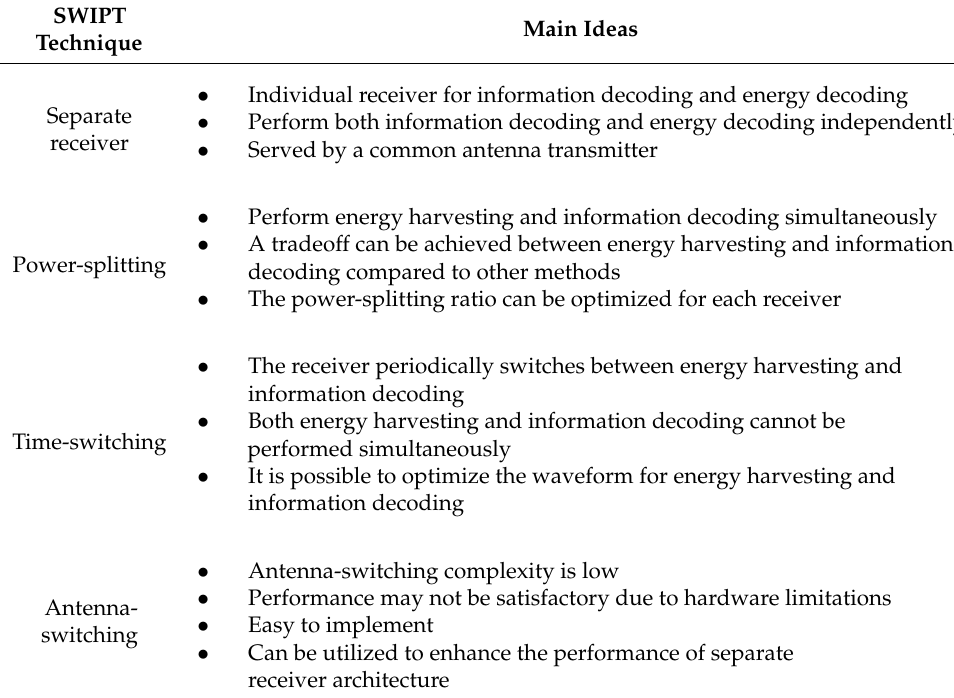
Table 4. Summary of SWIPT